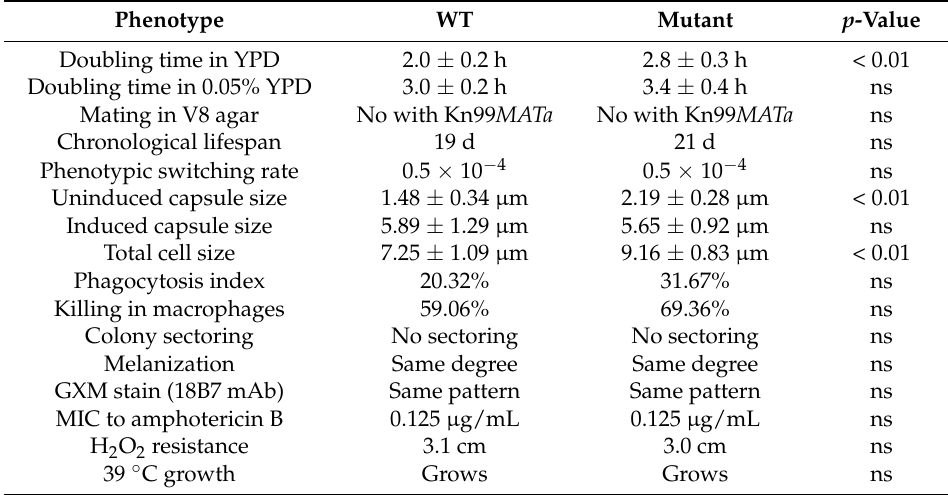
Table 2. Characterization of sir2 ∆ phenotypes in C. neoformans strain RC2.